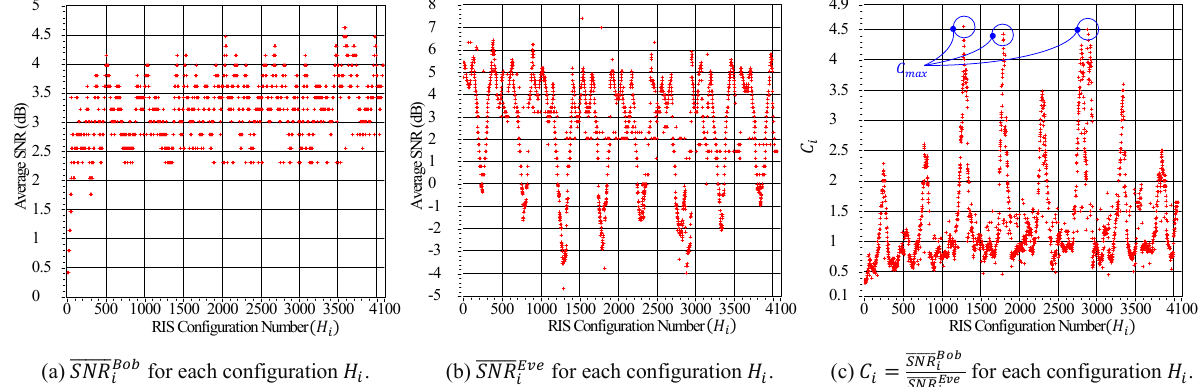
Figure 5. The average SNR values for different configurations and their optimized